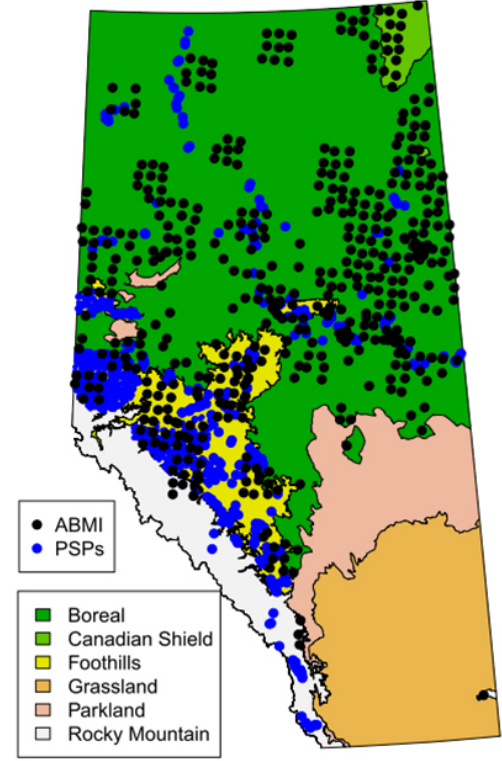
Figure 1. Spatial distribution of 1968 inventory plots in Alberta forests, Canada. Note that in western Alberta, some points represent several plots.